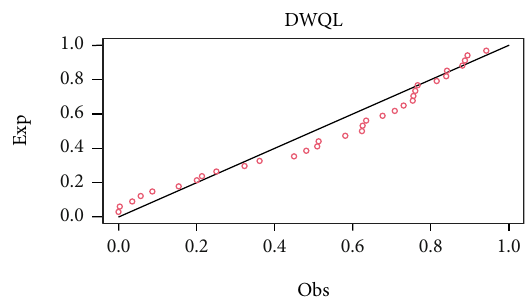
Figure 8: PP plot of the fi tted model for the fi rst data set.